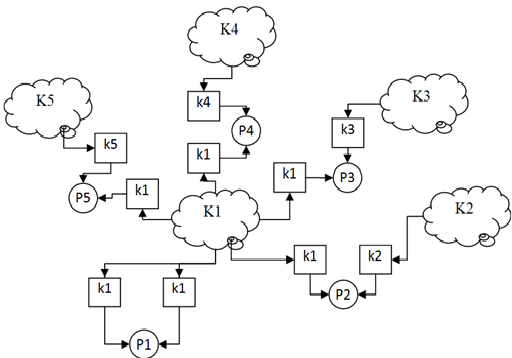
Figure 4. Schematic explanation for extended OVO